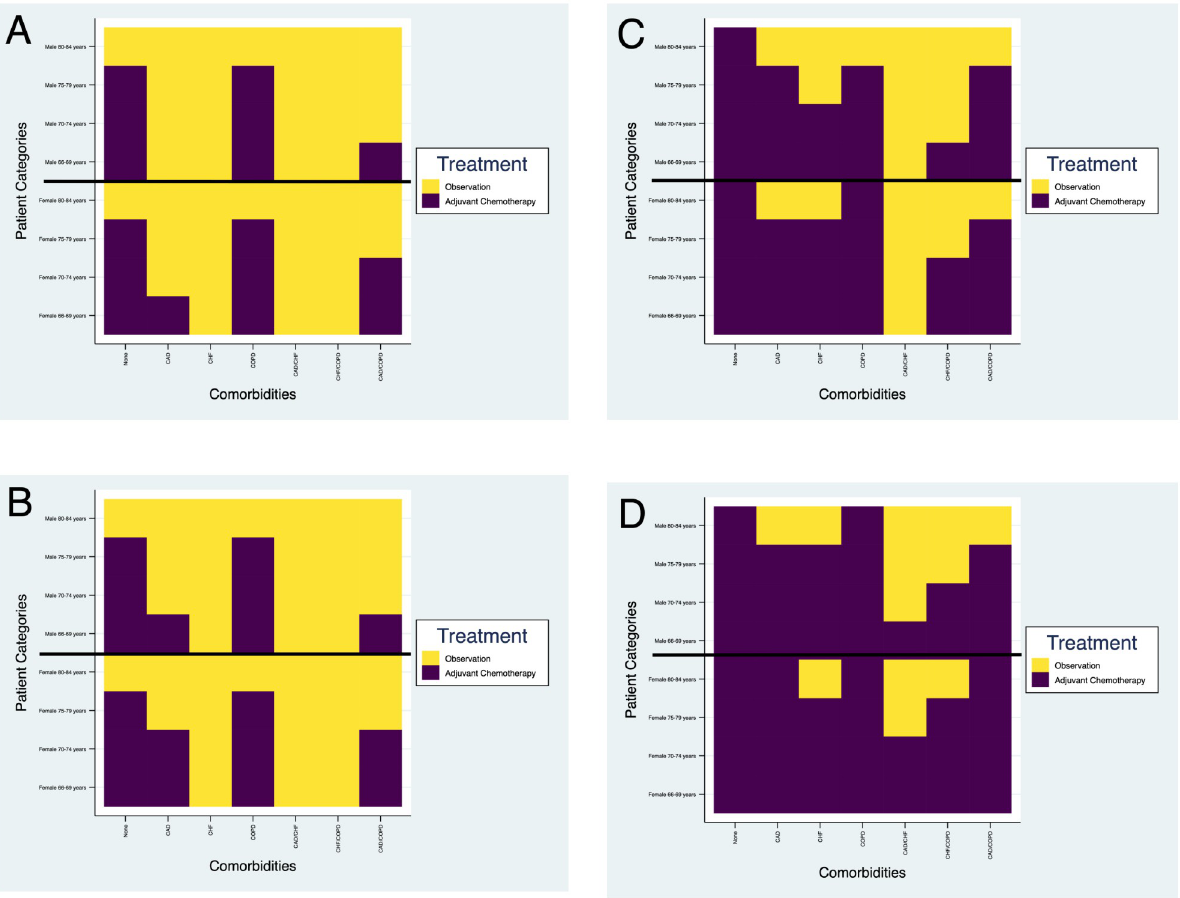
Fig 1. Estimated treatment strategy associated with greatest quality-adjusted life-year gains (QALY) by patient age, sex and comorbidity groups for non-small cell lung cancer according to stage (American Joint Committee on Cancer [AJCC] 8 th edition). (A) Stage IB; (B) Stage IIA; (C) Stage IIB; (D) Stage IIIA. Congestive heart failure (CHF) refers to mild/moderate